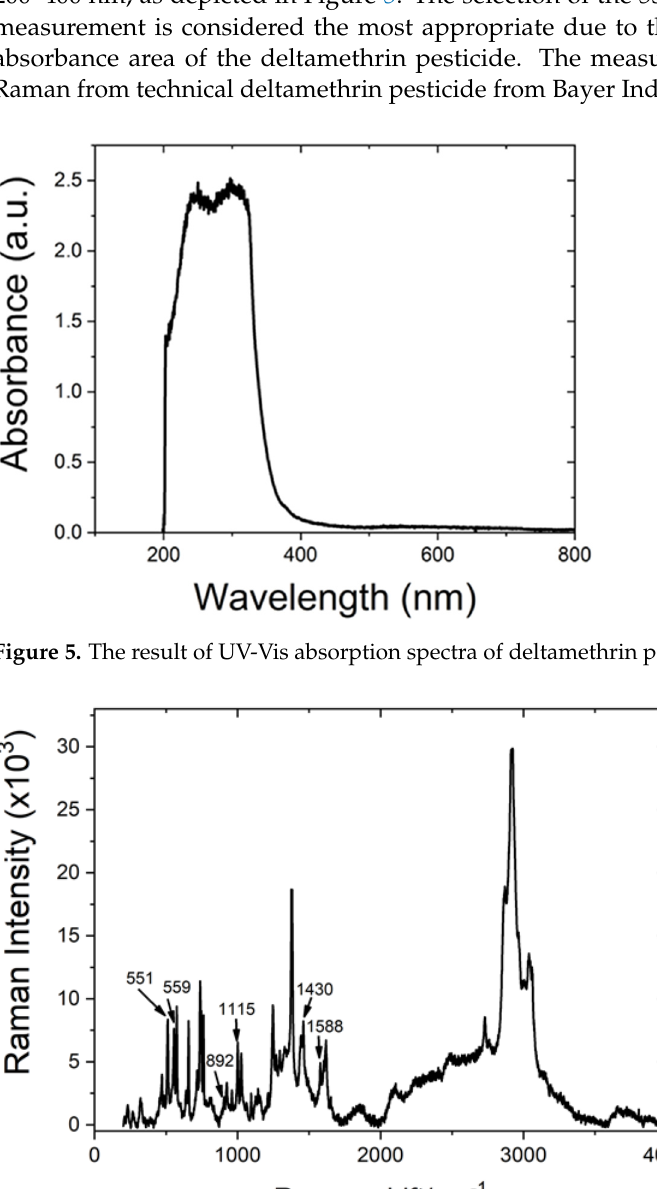
Figure 7. The Raman peak of brewed tea without deltamethrin pesticides .